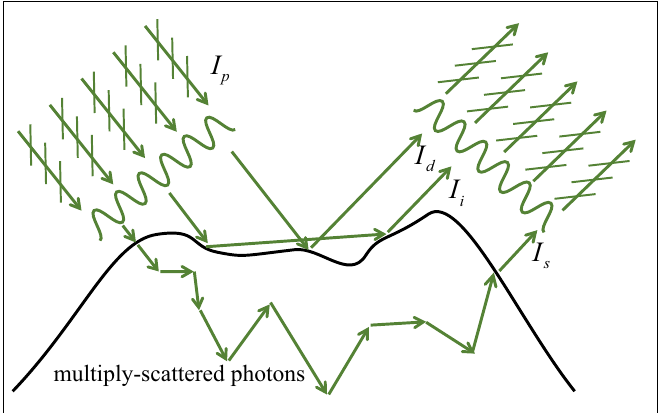
Figure 2. Diagram of the projection, reflection, and transmission of the sinusoidal optical signal on the surface of a translucent object. I p is the intensity of the projected fringe pattern; I d stands for the directly-reflected radiance; I i represents the radiance of interreflection; I s denotes the contribution from multiply-scattered